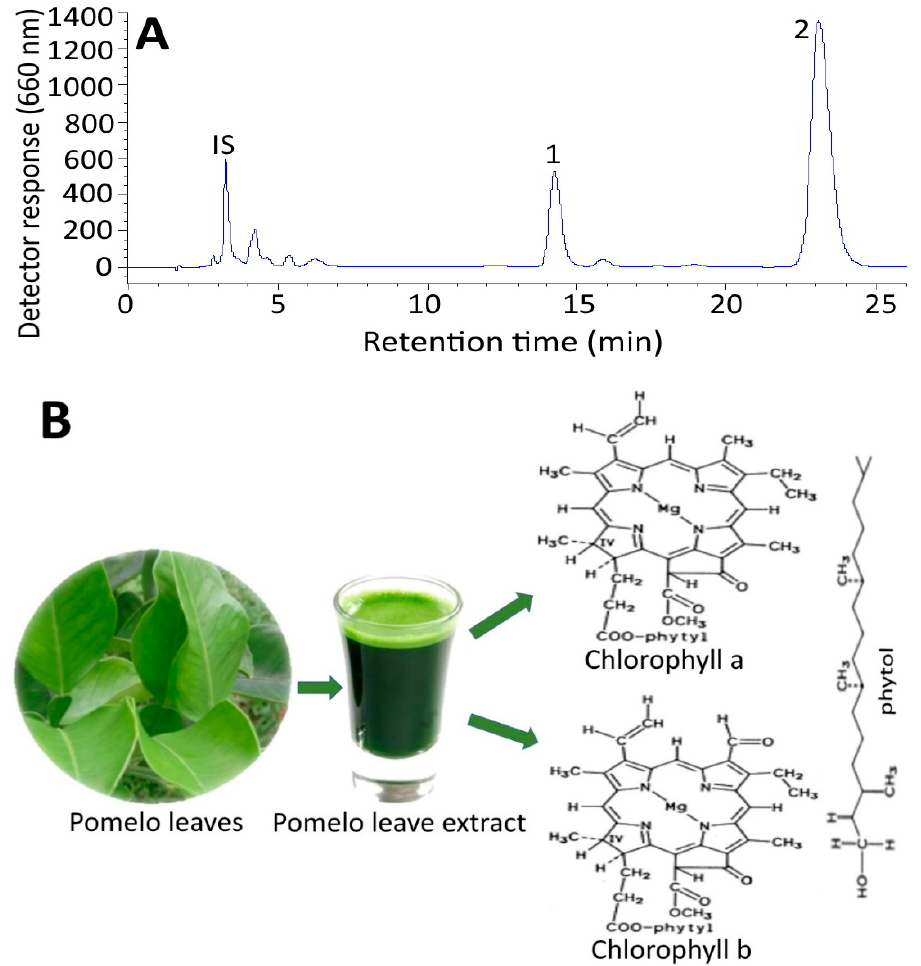
Figure 1. HPLC chromatogram of chlorophylls in pomelo extract ( A ) Peaks: IS, internal standard Fast Green FCF; 1, chlorophyll b; 2, chlorophyll a and ( B ) a schematic diagram showing the chemical structures of isolated chlorophyll a and chlorophyll b compounds from pomelo leaves.